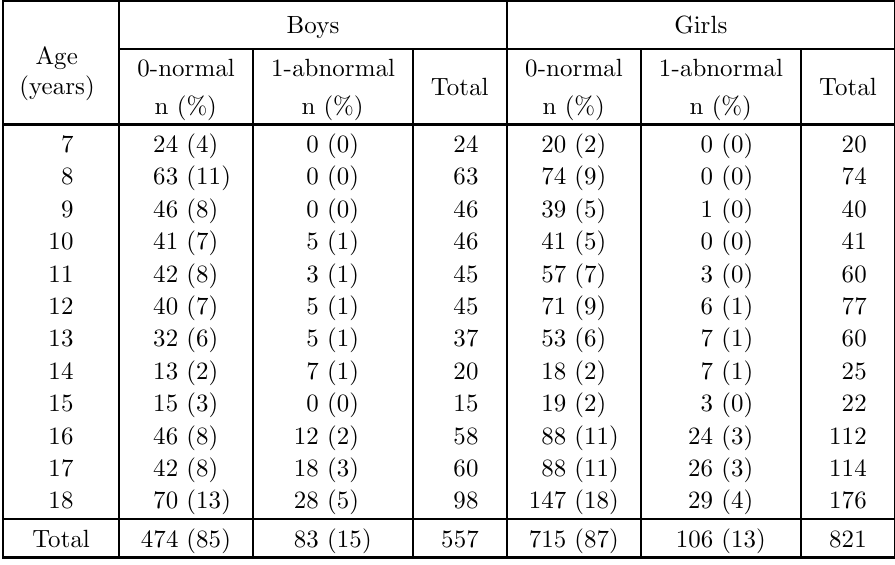
Table 1. The number of children with normal and abnormal blood pressure Boys Girls Age 0-normal 1-abnormal 0-normal 1-abnormal (years)